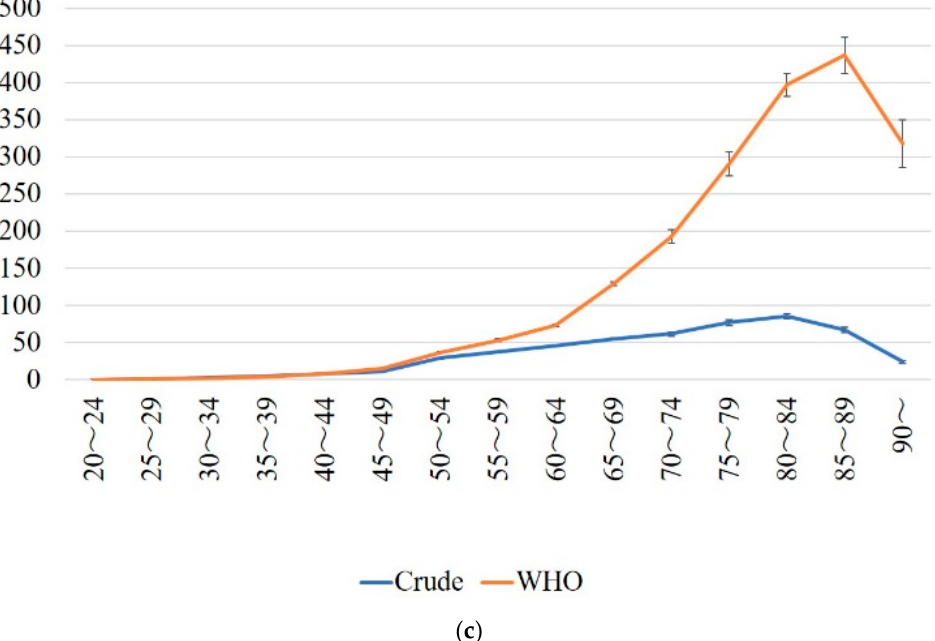
Figure 3. Annual incidence of OCTR and ECTR. Mean annual incidence of OCTR ( a ), ECTR ( b ), and WHO World Standard Population adjustment and crude annual incidence of CTR ( c ) per 100,000 people. OCTR; open carpal tunnel release, ECTR; endoscopic carpal tunnel release, CTR; carpal tunnel release.